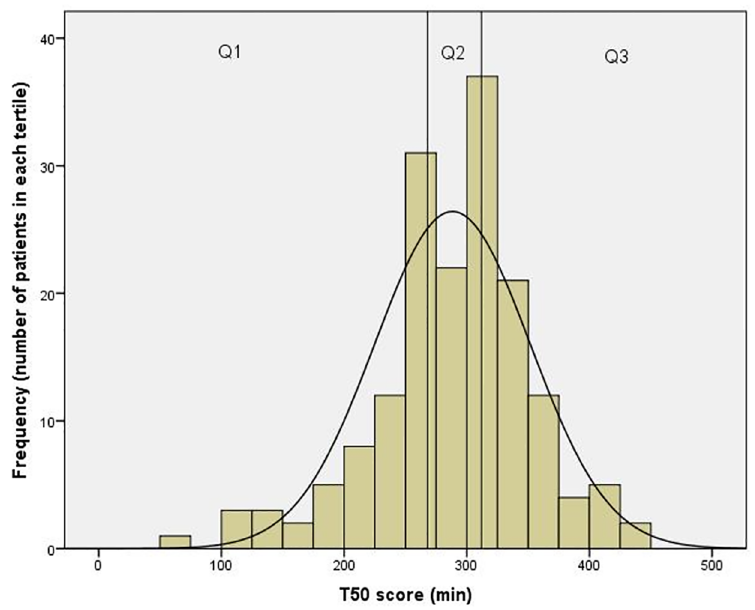
Fig 1. Distribution of serum calcification propensity score in SLE patients. Histogram of serum calcification propensity score (T 50 ) distribution in SLE patients (Kurtosis 1.252, Skewness -0.623). Q1, Q2 and Q3 represent tertiles of T 50